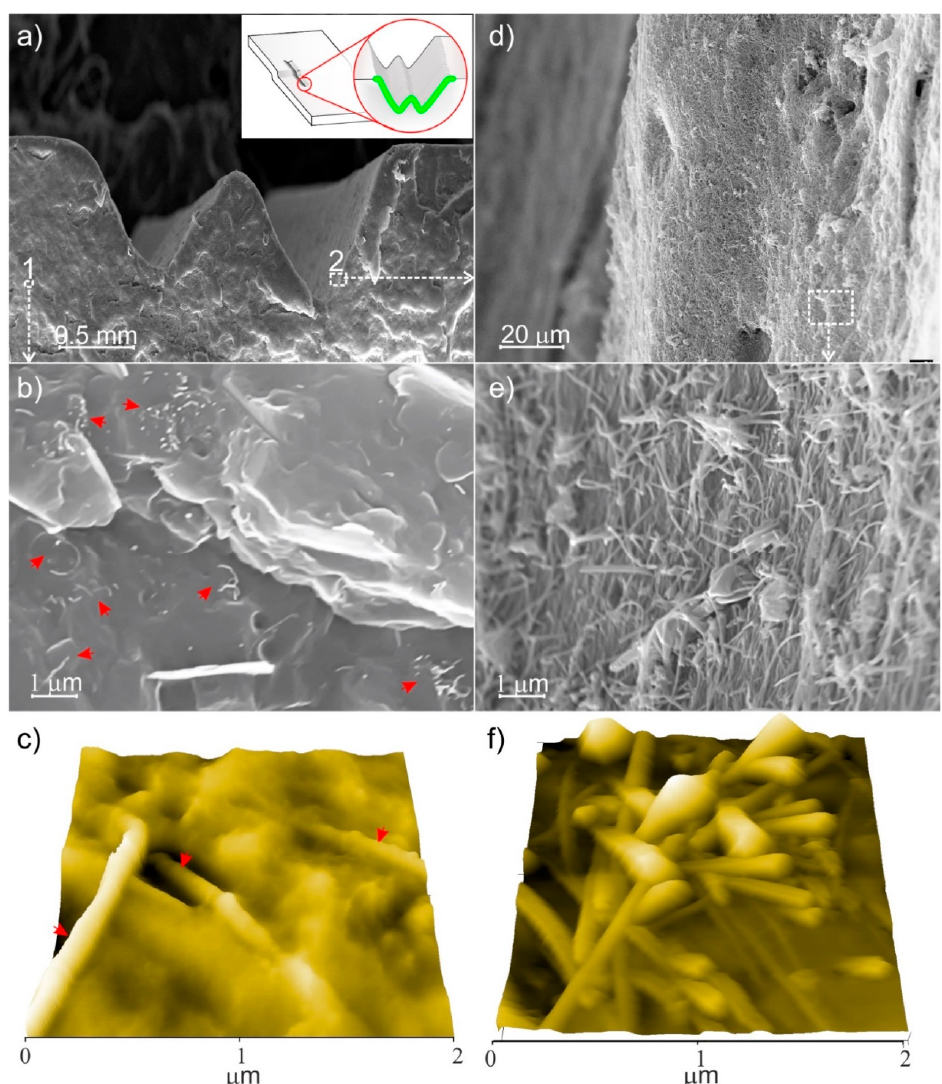
Figure 7. ( a ) Cross-sectional SEM image of the MWCNT/polymer composite (MWCNTs 1.5 wt.%) Figure 7. a) Cross-sectional SEM image of the MWCNT/polymer composite (MWCNTs 1.5 wt.%) along the CO 2 -laser irradiated region; b) SEM enlarged view of 1-selected area in a) panel and c) along the CO 2 -laser irradiated region; ( b ) SEM enlarged view of 1-selected area in ( a ) panel and 3D AFM image, both representative of (untreated) and bulk regions; d) and e) SEM enlarged ( c ) 3D AFM image, both representative of (untreated) and bulk regions; ( d ) and ( e ) SEM enlarged views collected at the different magnification of 2-selected area in a) panel, f) 2 × 2 µm 3D AFM views collected at the different magnification of 2-selected area in ( a ) panel, ( f ) 2 × 2 µ m 3D AFM image at the surface of the channel walls. Arrows in b) and c) correspond to isolated nano- image at the surface of the channel walls. Arrows in ( b , c ) correspond to isolated nanotubes/small tubes/small bundles dispersed in the polymer matrix. In the inset of a) the profile after the CO 2 - laser treatment obtained with a pair of two parallel irradiation paths. bundles dispersed in the polymer matrix. In the inset of ( a ) the profile after the CO 2 -laser treatment obtained with a pair of two parallel irradiation